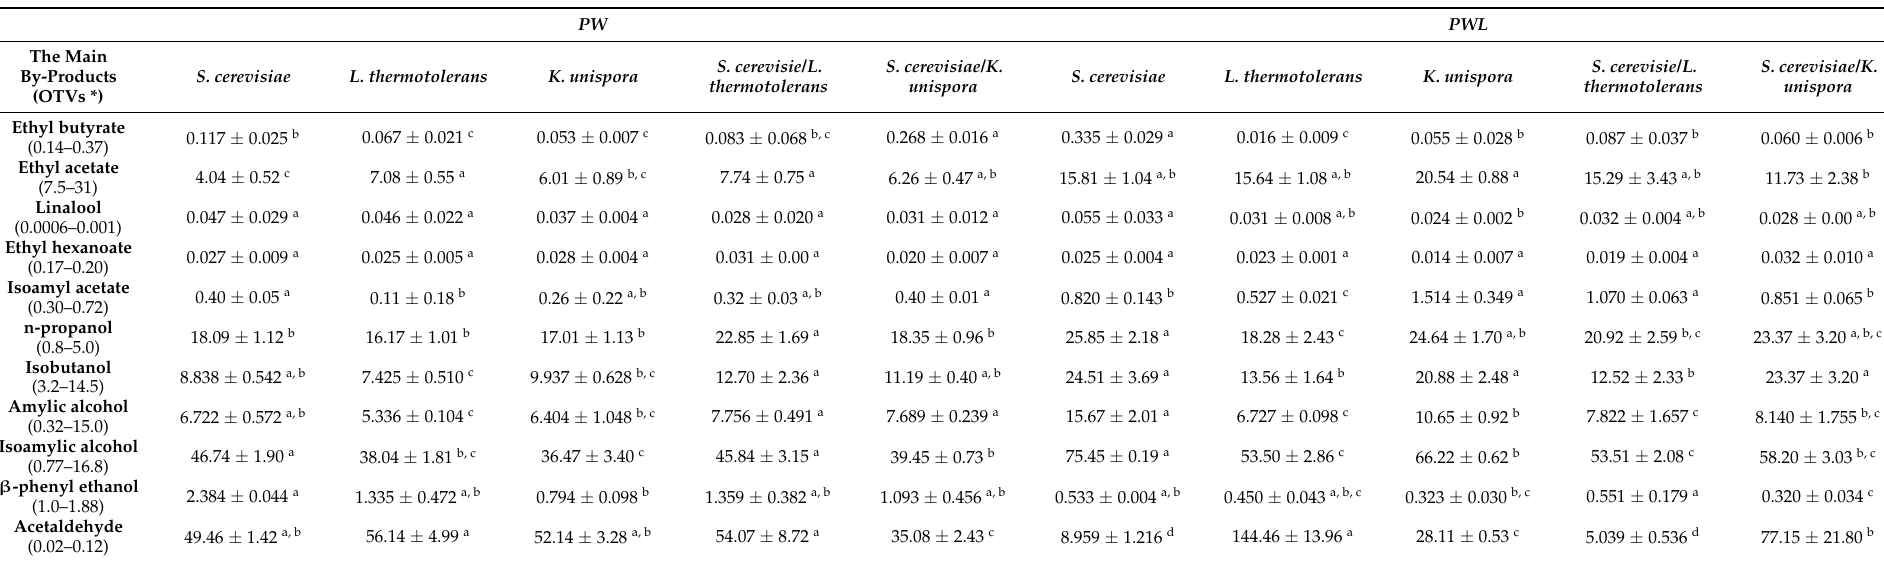
Table 3. The main by-products and volatile compounds (mg/L) of pure and mixed fermentation trials carried out in PW (pils wort) and PWL (pils wort with HRL). Data are means ± standard deviations from three independent experiments. Data with different superscript letters ( a, b, c, d ) within each row between